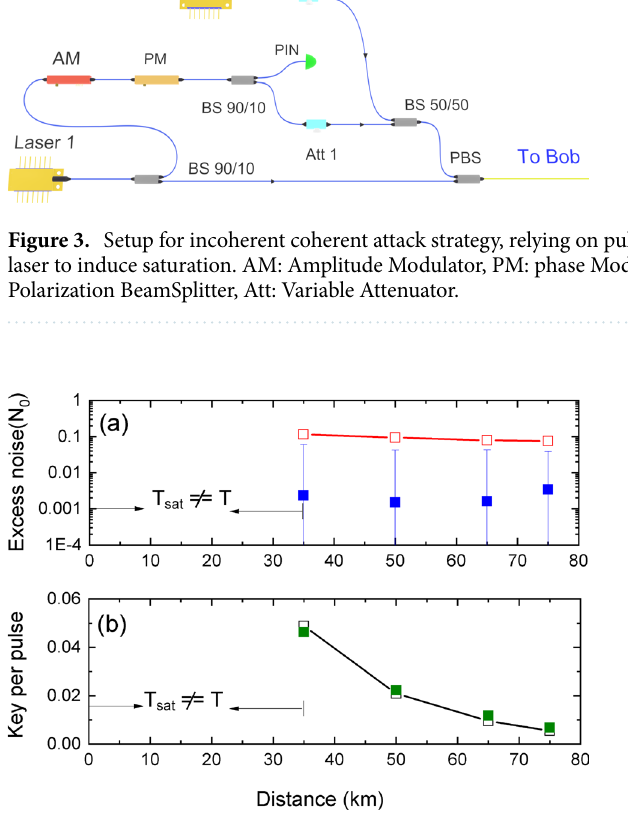
Figure 4. Results:- attack with incoherent light. ( a ) excess noise at Alice. Red squares indicate the null key noise threshold and blue squares the estimated values of ξ sat . ( b ) key rate. Black squares are simulated values of final key per pulse while Green squares are from the experiment. Error bars are one standard deviation of fluctuations among ten smaller data block of size 10 7 . Success condition of T sat = T can not be fulfilled below 35